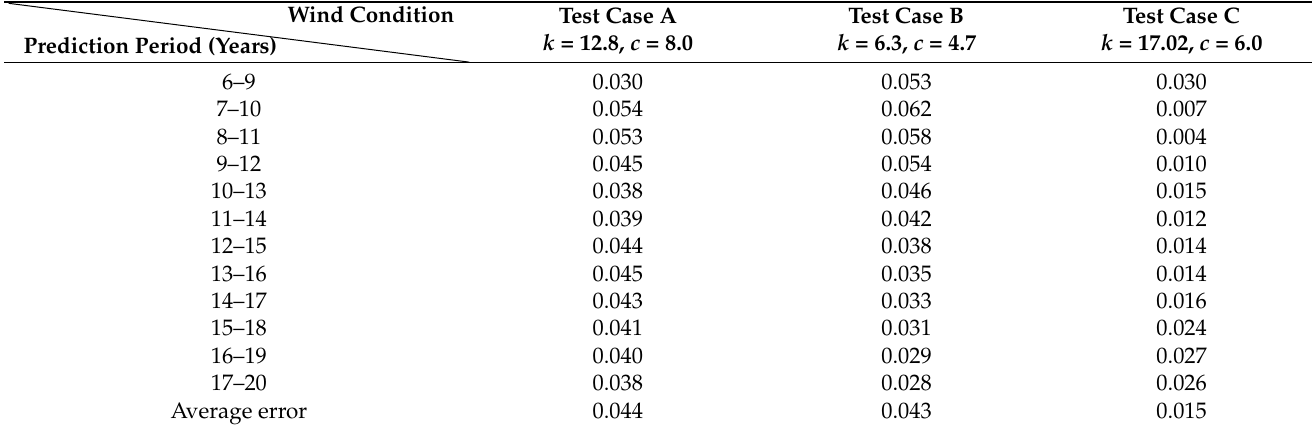
Table 4. Prediction error (%) for each test case for different three-year prediction periods.